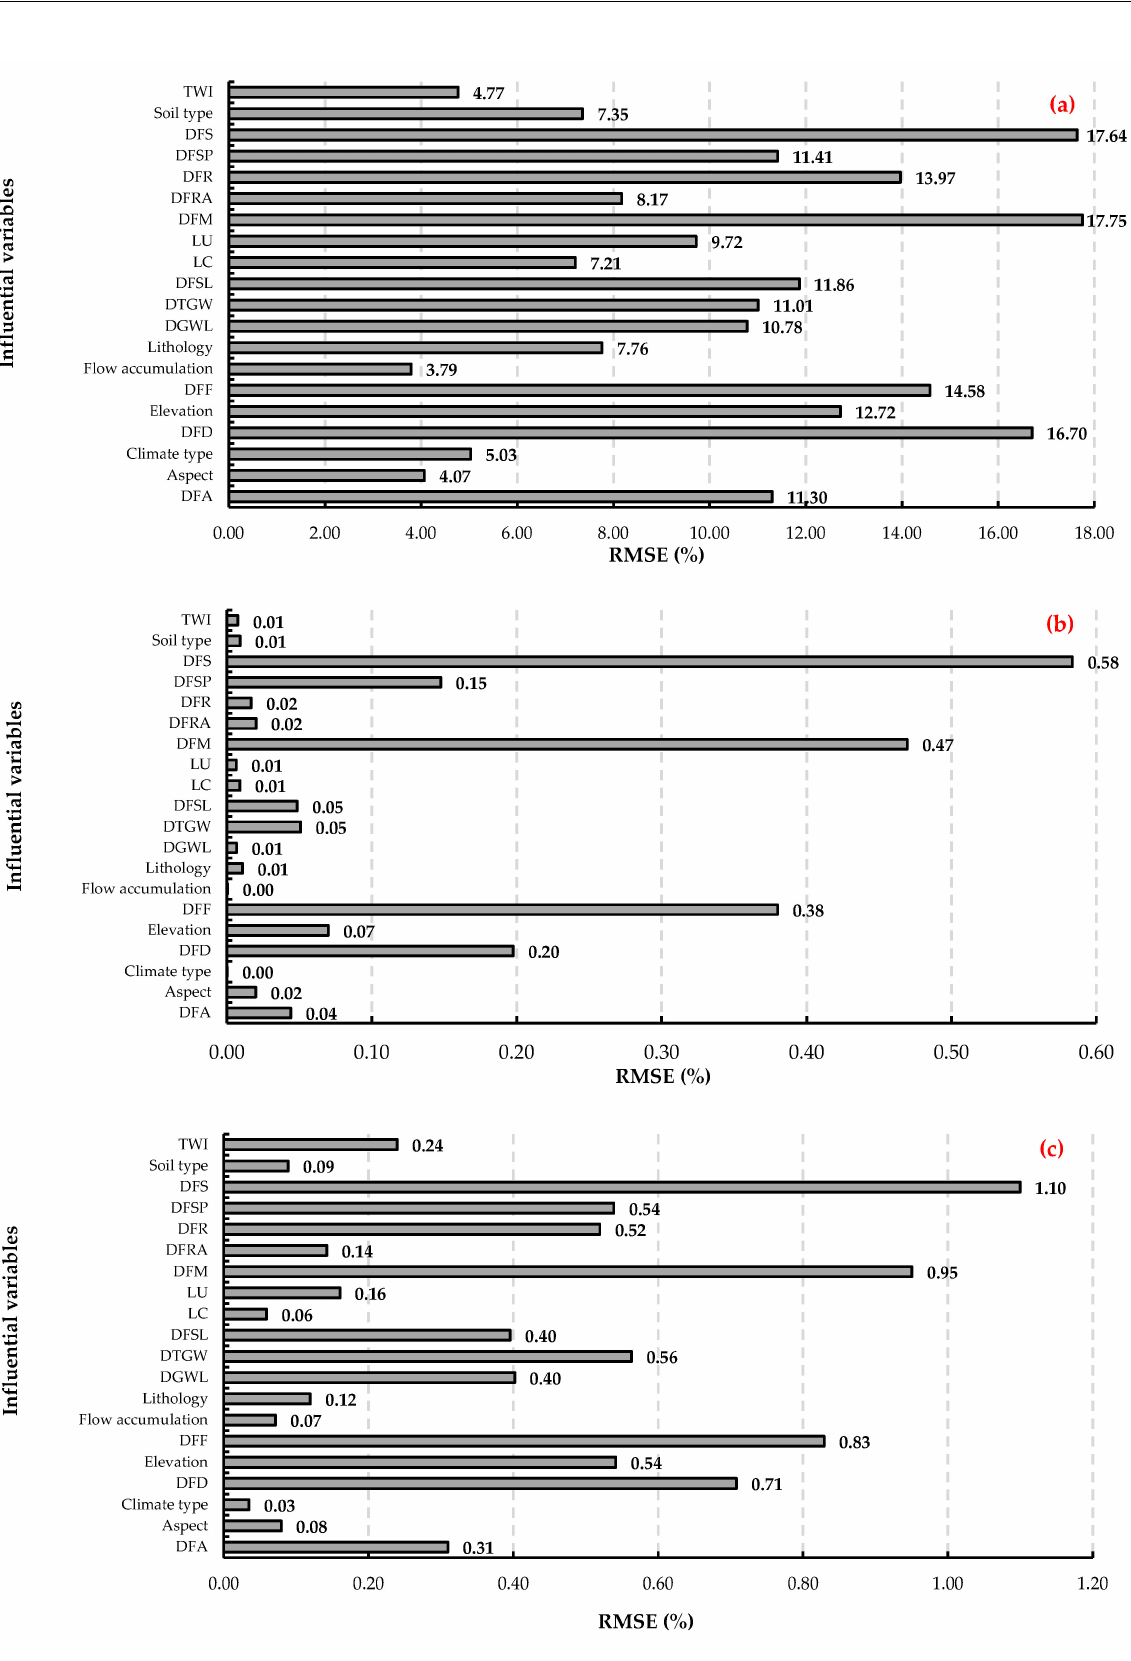
Figure 7. Results of the jackknife test in the various machine learning models: ( a ) random forests (RF), ( b ) k-nearest neighbors (KNN), and ( c ) classification and regression trees (CART). Abbreviations are described in Table